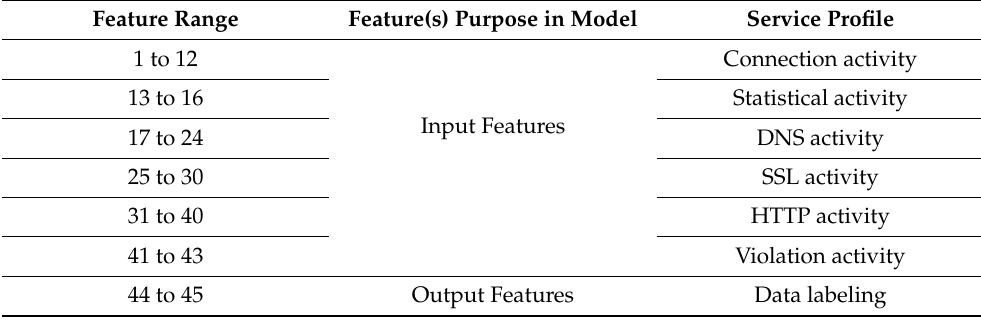
Table 3. Service profile of TON IoT train-test network dataset features [24].